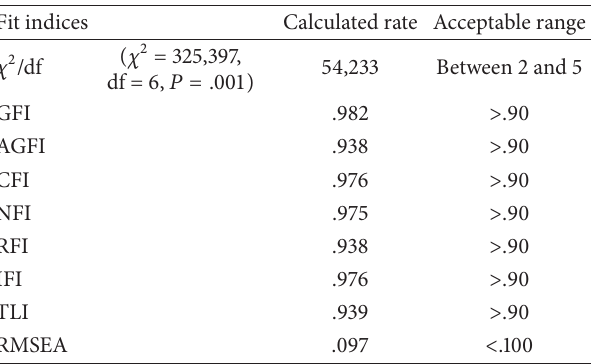
Table 4: Fit indices concerning the established model.